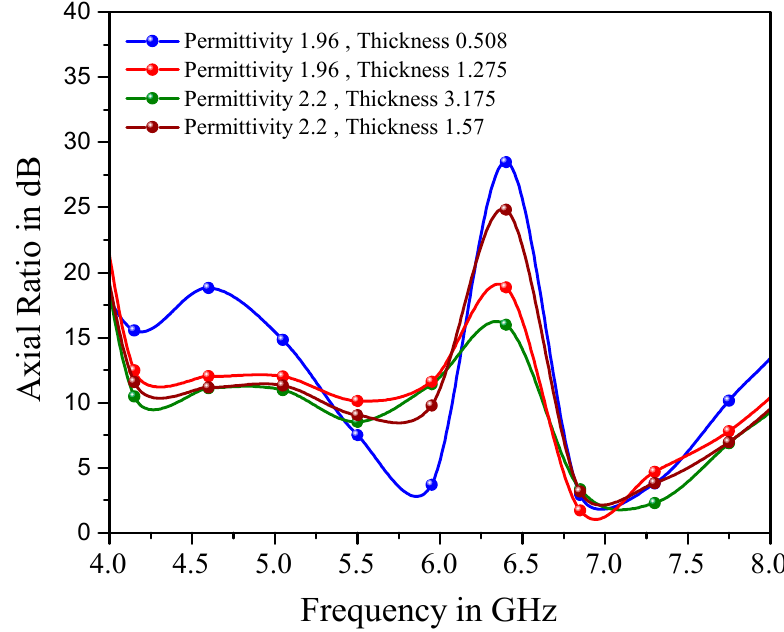
Figure 13. Simulated axial ratios of the antennas over the frequency range of interest.